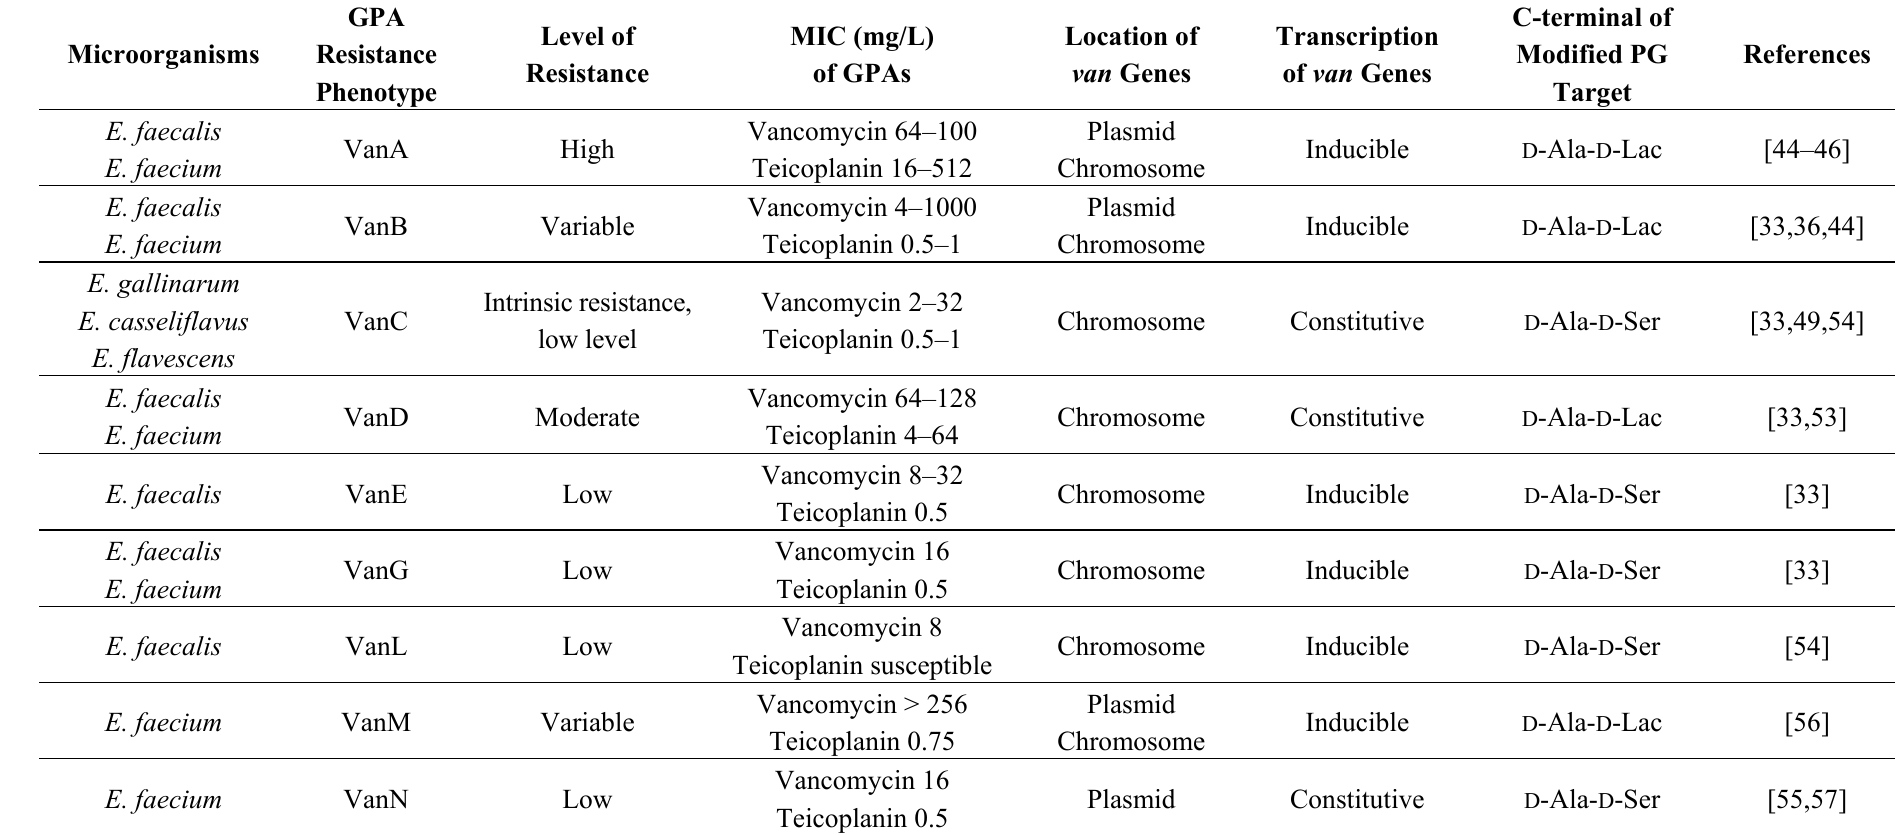
Table 2. Features of GPA resistance in enterococci. PG,